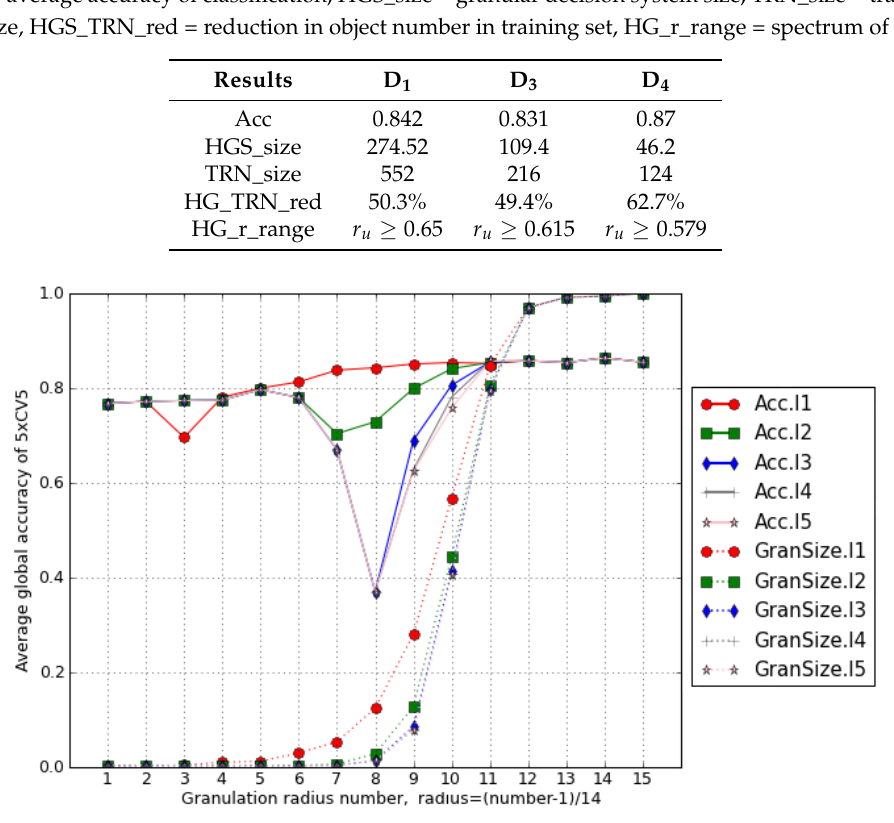
Figure 1. Visualization of results for Australian